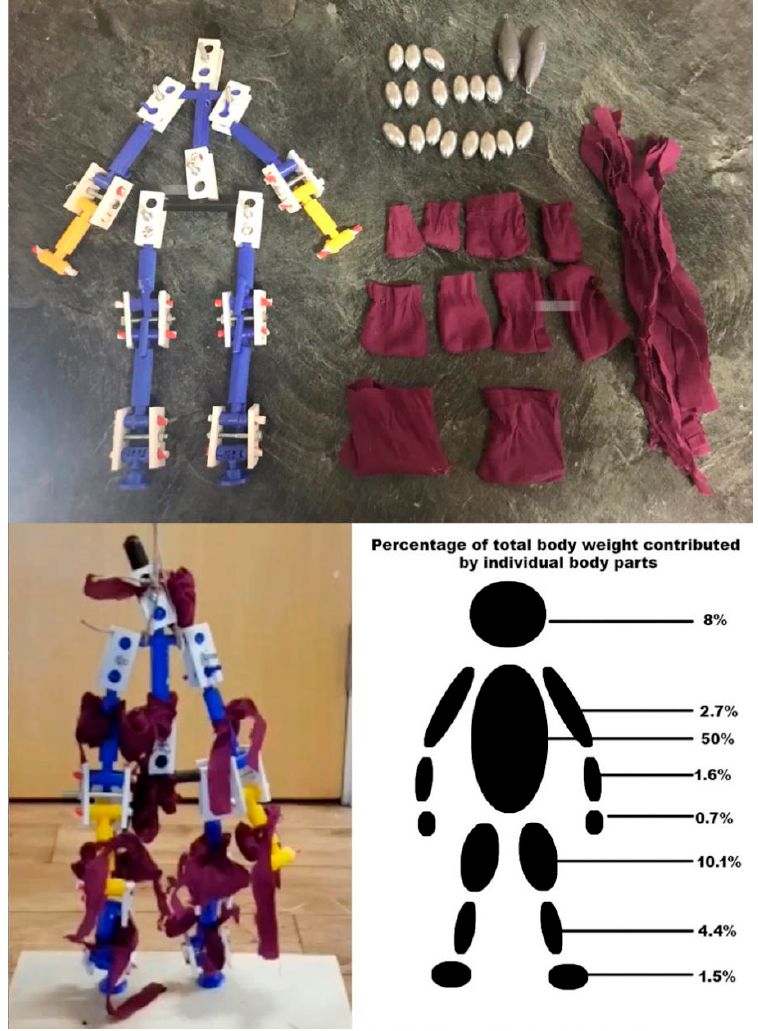
Figure 4. Model load (data source